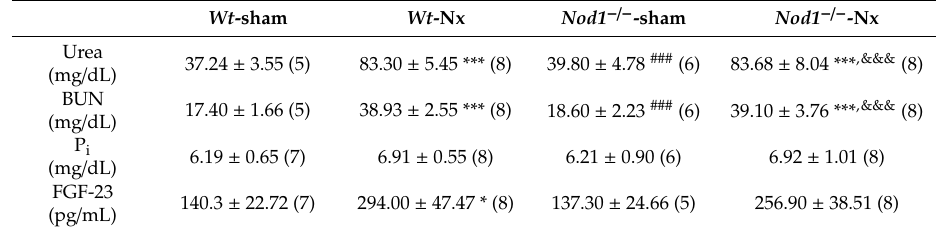
Table 2. Biochemical plasma parameters in Wild-type and Nod1 − / − mice subjected or not to experimental